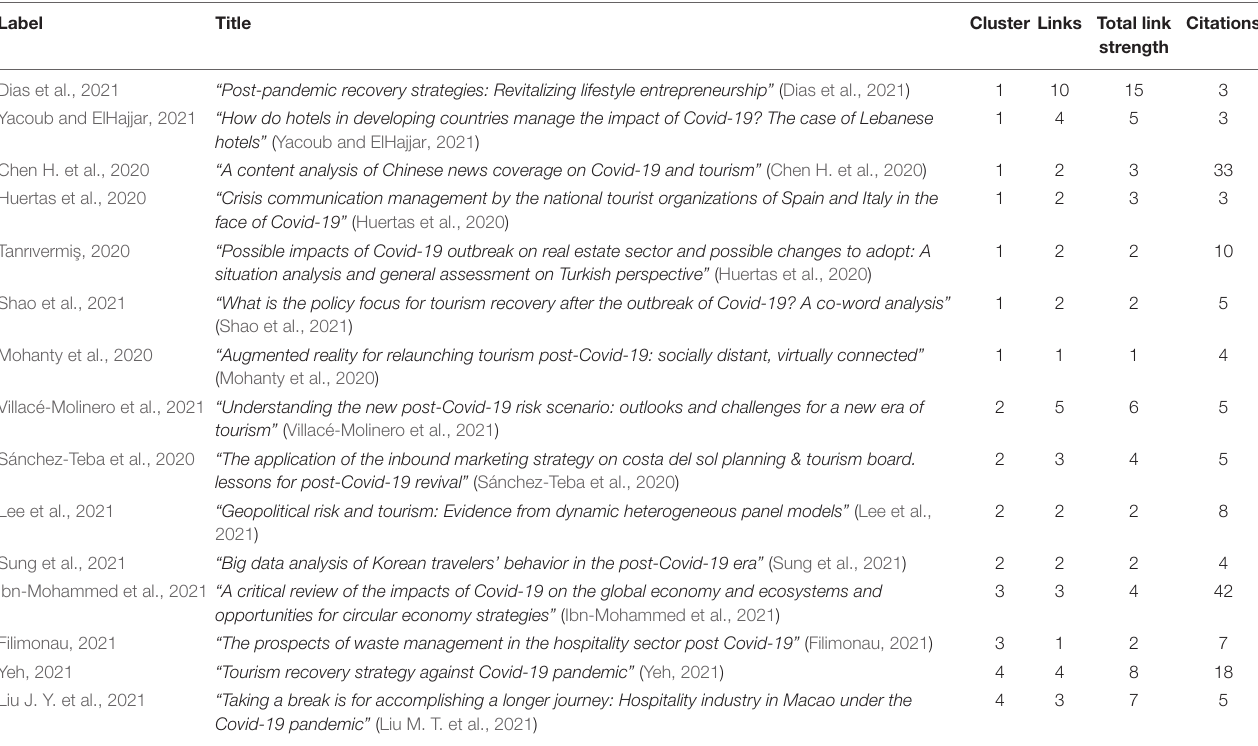
FIGURE 4 | Bibliometric coupling. TABLE 11 | Publication clustering from bibliometric